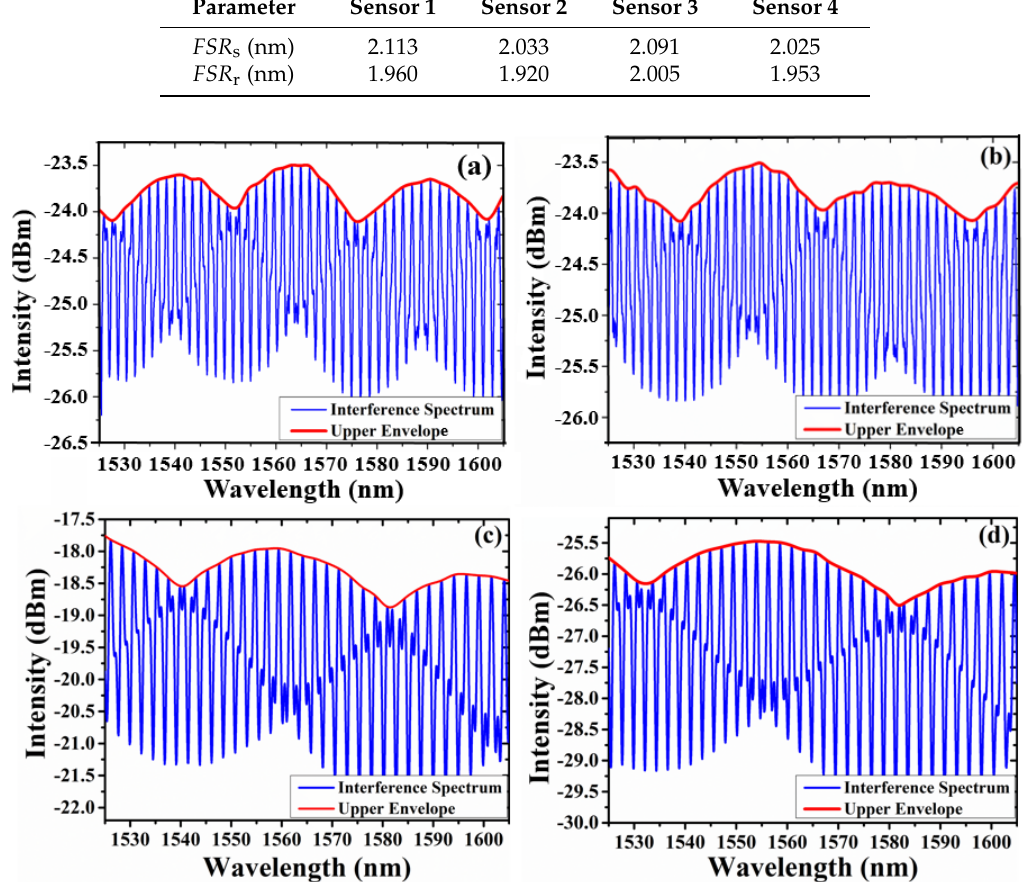
Figure 5. Interference spectrums of four sensors under 0 MPa: ( a ) sensor 1, ( b ) sensor 2, ( c ) sensor 3, ( d ) sensor 4.